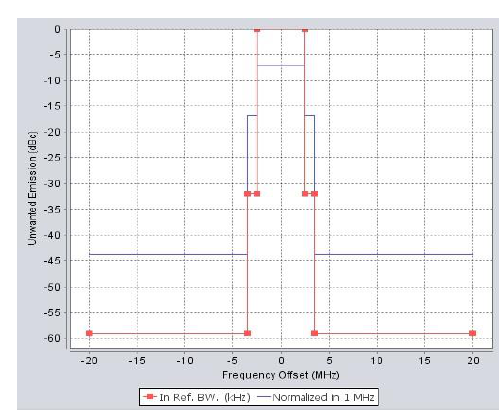
Fig. 10. LTE BS emission mask based on ETSI TS 136 104 V10.2.0.